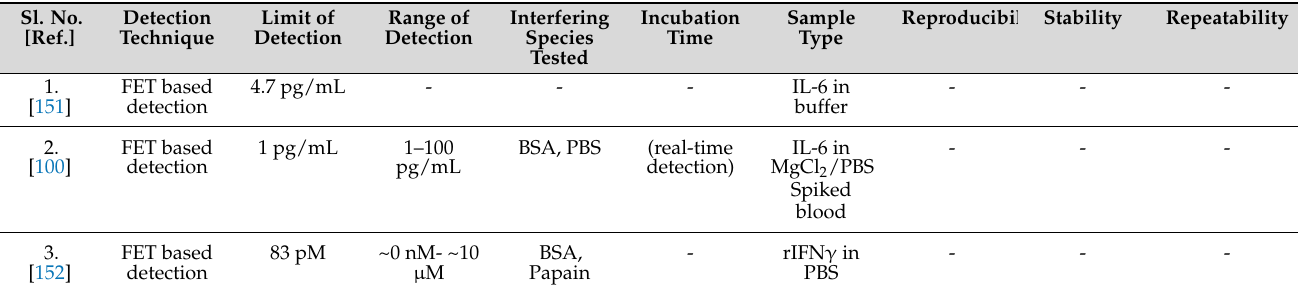
Table 16. FET-based biosensors: Specifications and performance characteristics. Sl. No. [Ref.]